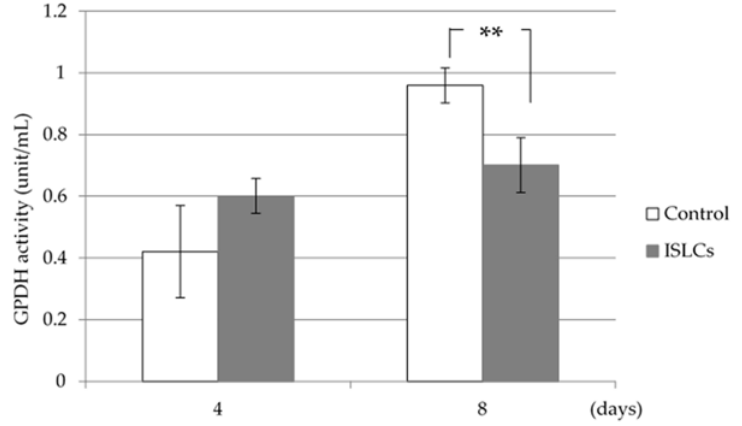
Figure 2. Effect of ISLCs on the GPDH activity of 3T3 ‐ L1 cells 4 and 8 days after differentiation. The cells were cultured for 4 and 8 days in medium containing 1.0 mg/mL ISLCs. The cells in the medium without ISLCs were used as a control. Values are expressed as the mean ± SD; ** p < 0.01, compared to control cells.